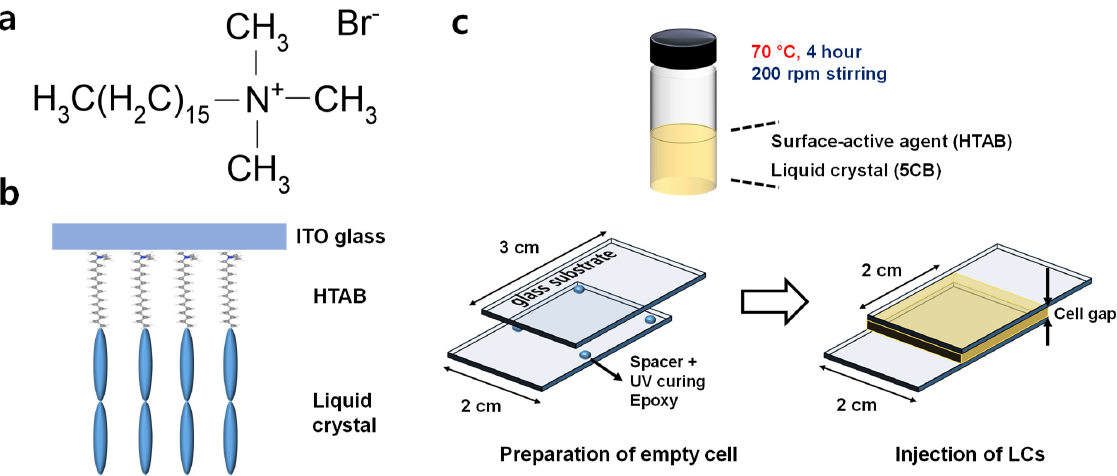
Figure 1. Schematics of ( a ) chemical structure of HTAB, ( b ) principle of vertical alignment of LC molecules mixed with HTAB, and ( c ) cell fabrication.